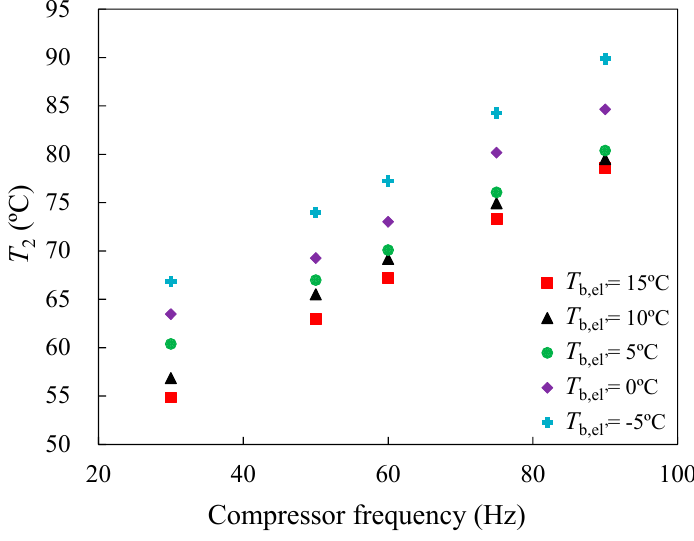
Figure 10. The compressor discharge temperature T 2 as a function of compressor frequency.